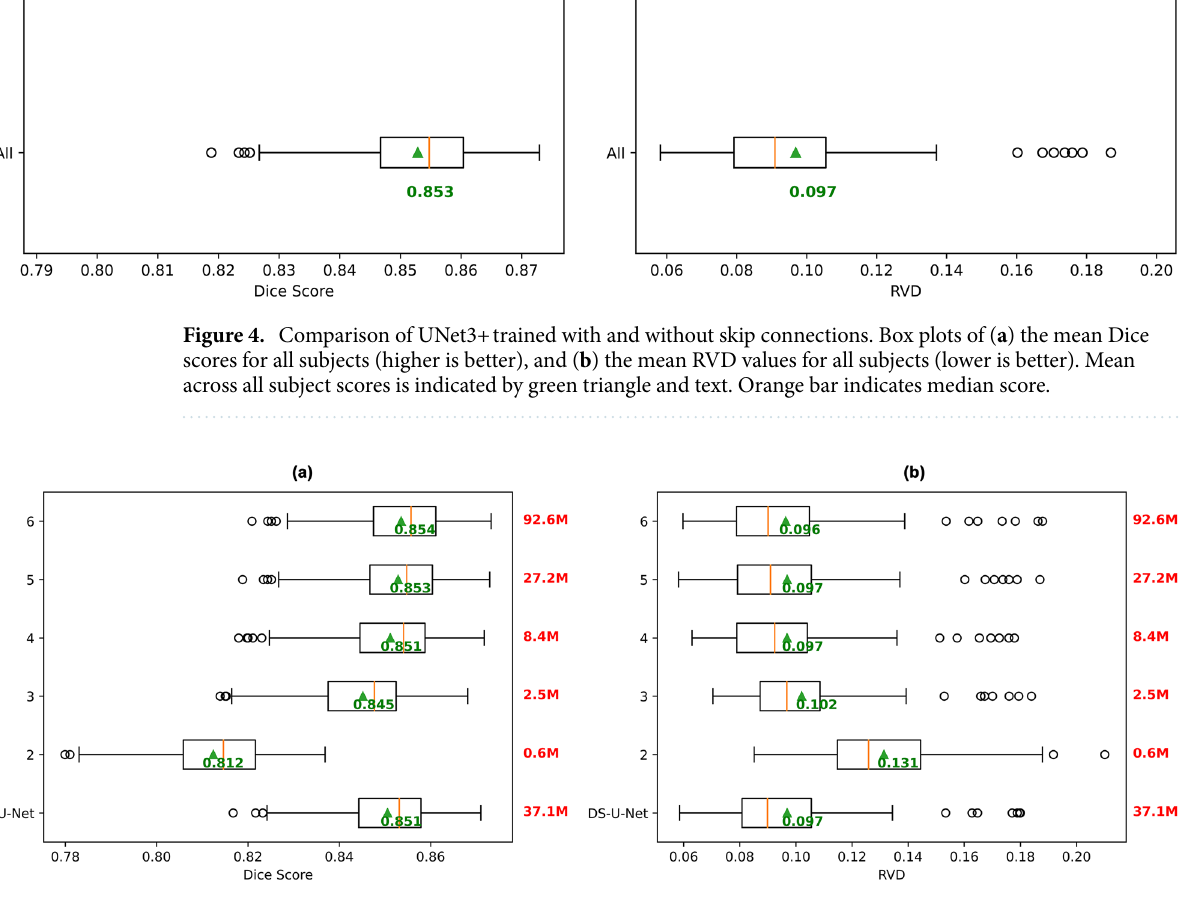
Figure 5. Box plots of performance of UNet3+ models with different depths (2–6), with DS-U-Net as a baseline for comparison. The depth of the network corresponds to the number of encoding and decoding nodes in the U-shape of the network. Number of parameters (in millions) for each model is depicted in red text. Box plots of ( a ) the mean Dice scores for all subjects (higher is better), and ( b ) the mean RVD values for all subjects (lower is better). Mean across all subject scores is indicated by green arrow and text. Orange bar indicates median score. See Fig. S5 for the depth 5 architecture diagram, and Supplementary Figs. S6-9 for depths 2, 3, 4 and